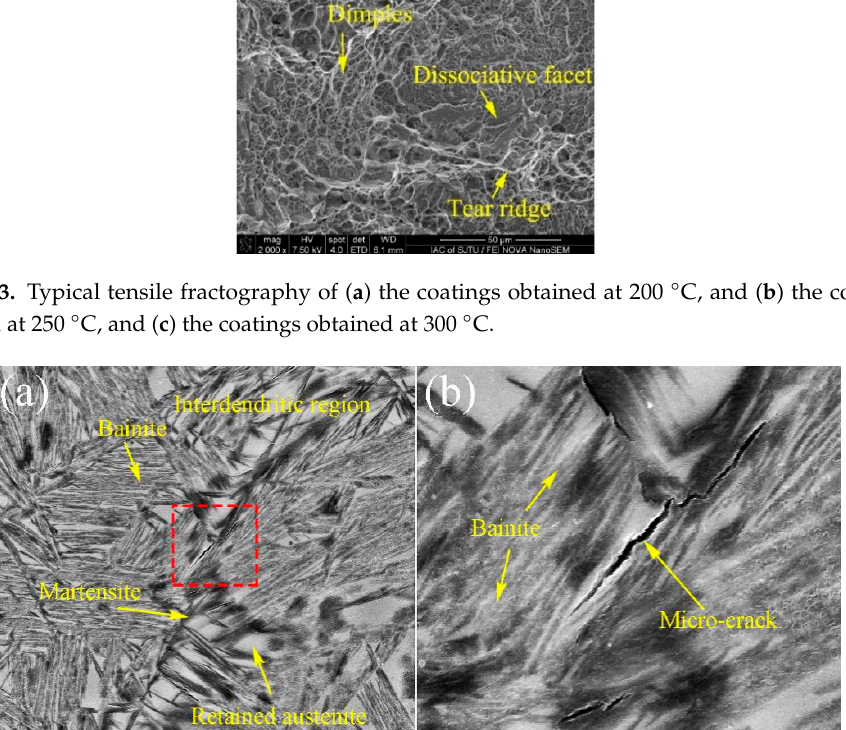
Figure 14. The micro-crack in the microstructure under the water cooling and the ε -martensite in the blocky austenite ( a ), the magnified view of the cracks ( b ).